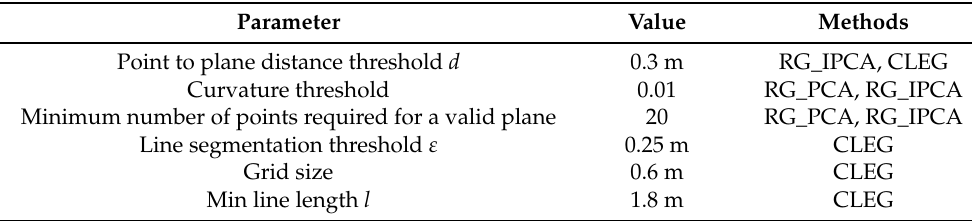
Table 6. Parameters used in the comparison test.